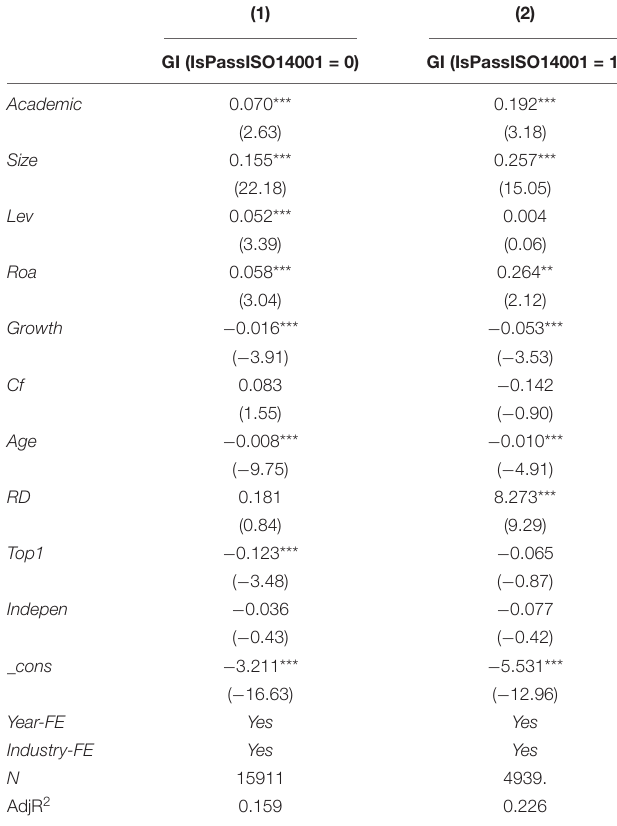
TABLE 10 | Mechanism test results (environmental